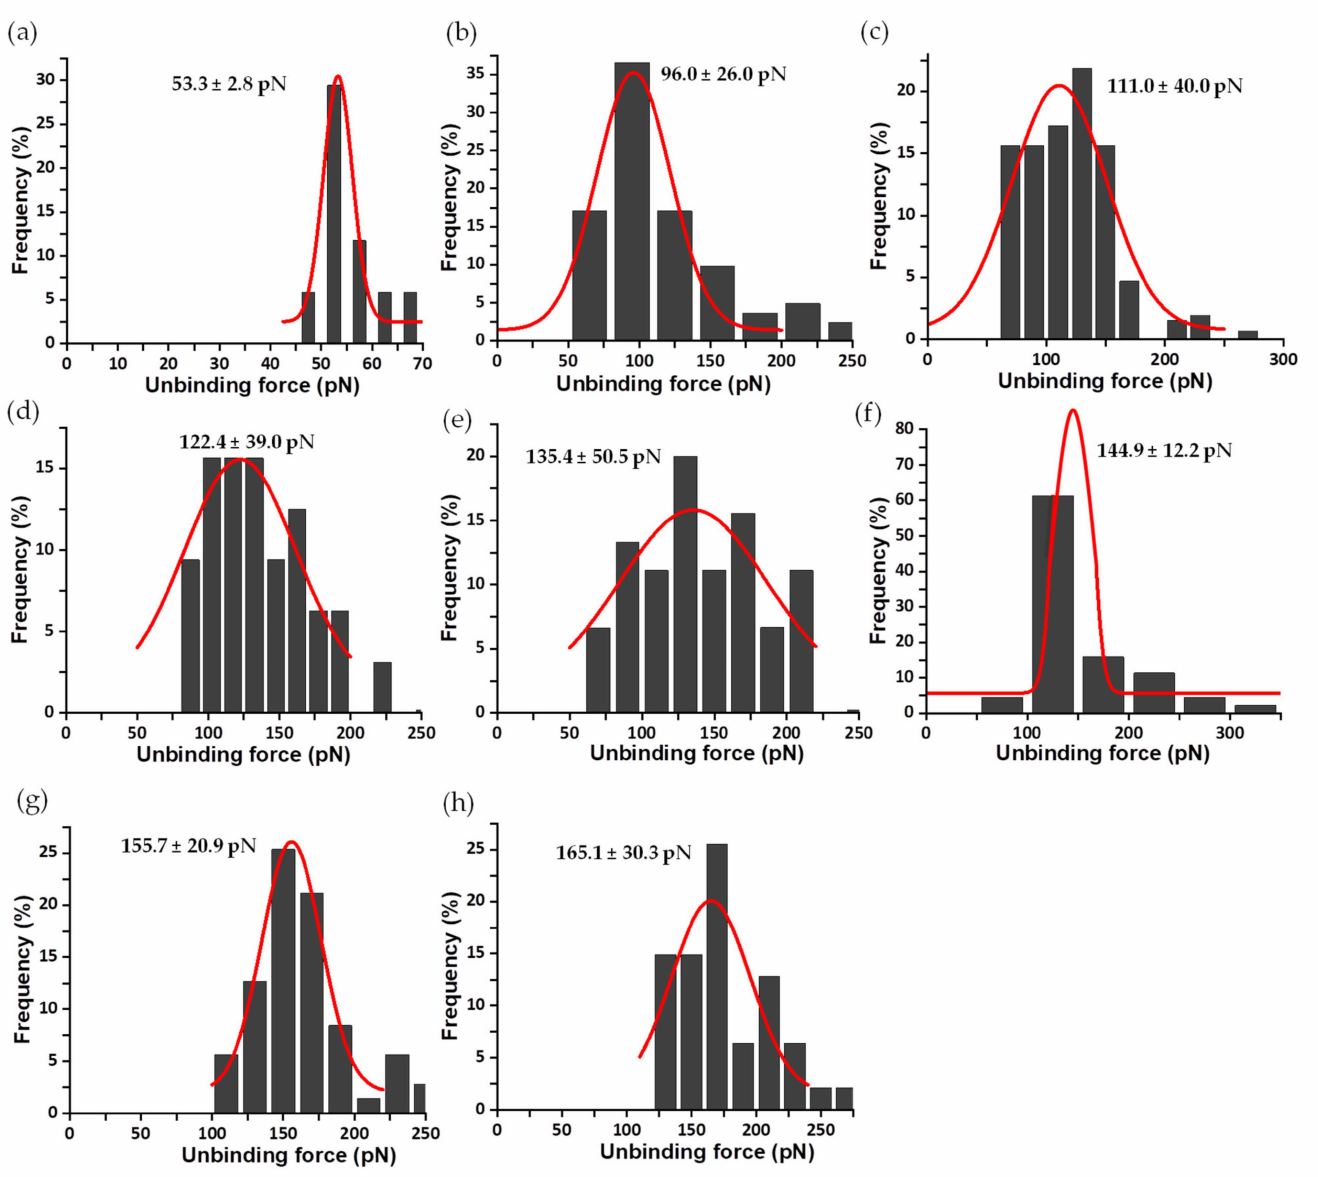
Figure 8. Force histogram distributions for Y303F AnFNR ox :NADP + complexes. Data force obtained operating at R values of 3 ( a ), 21 ( b ), 28 ( c ), 46 ( d ), 57 ( e ), 65 ( f ), 77 ( g ) and 96 ( h ) nN/s. The width of the bars varies in each case, depending on the optimum fit with the Gaussian function shown in red. Data from R 10 nN/s were also measured but are shown below. The fitting provides the most probable unbinding forces corresponding to the rupture of a single complex and is shown on the corresponding